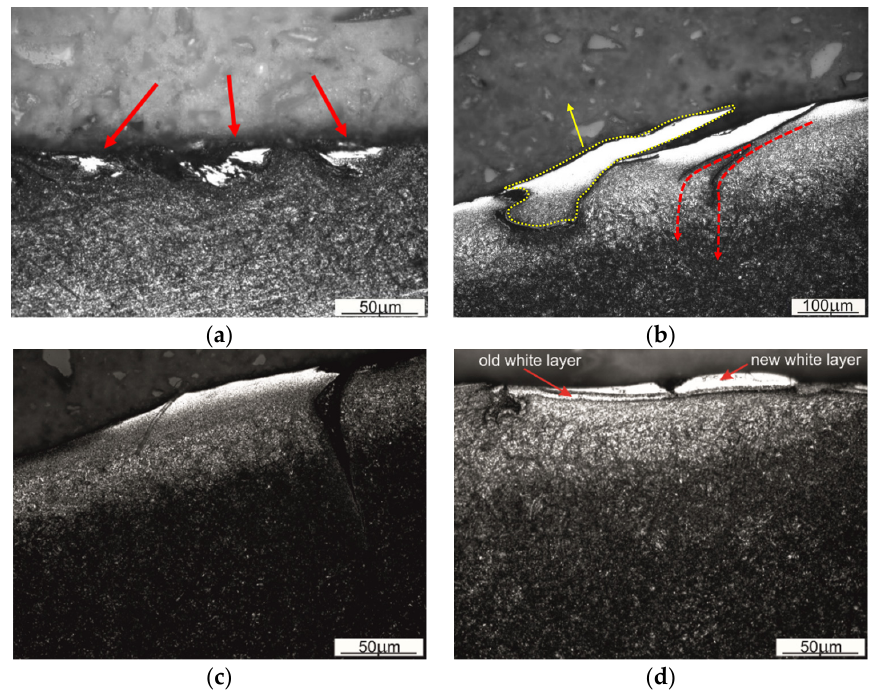
Figure 6. The top layer showing microstructural changes on the surface of the sample in the flash area to the web edge: ( a ) perpendicular (red arrows indicate the white layer), ( b , c ) parallel (yellow dotted line indicates the corrugation of the white layer, and red dotted lines indicate the course of further development of the crack formed between the white layer and the rest of the material, and ( d ) parallel at the fillet radius.